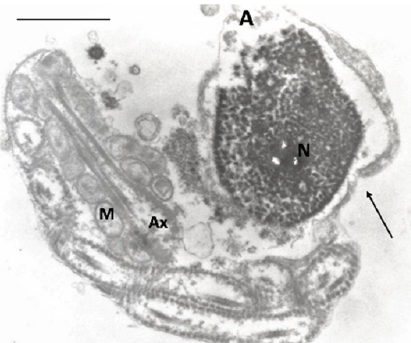
Figure 1. TEM micrograph of a longitudinal section of a necrotic spermatozoon with an altered nucleus and disrupted chromatin; the acrosome is empty; the axonemal components are disorganized and coiled. The plasma membrane is broken (arrow). A, acrosome; N, nucleus; M, mitochondria; Ax, axoneme. Bar: 3µm.